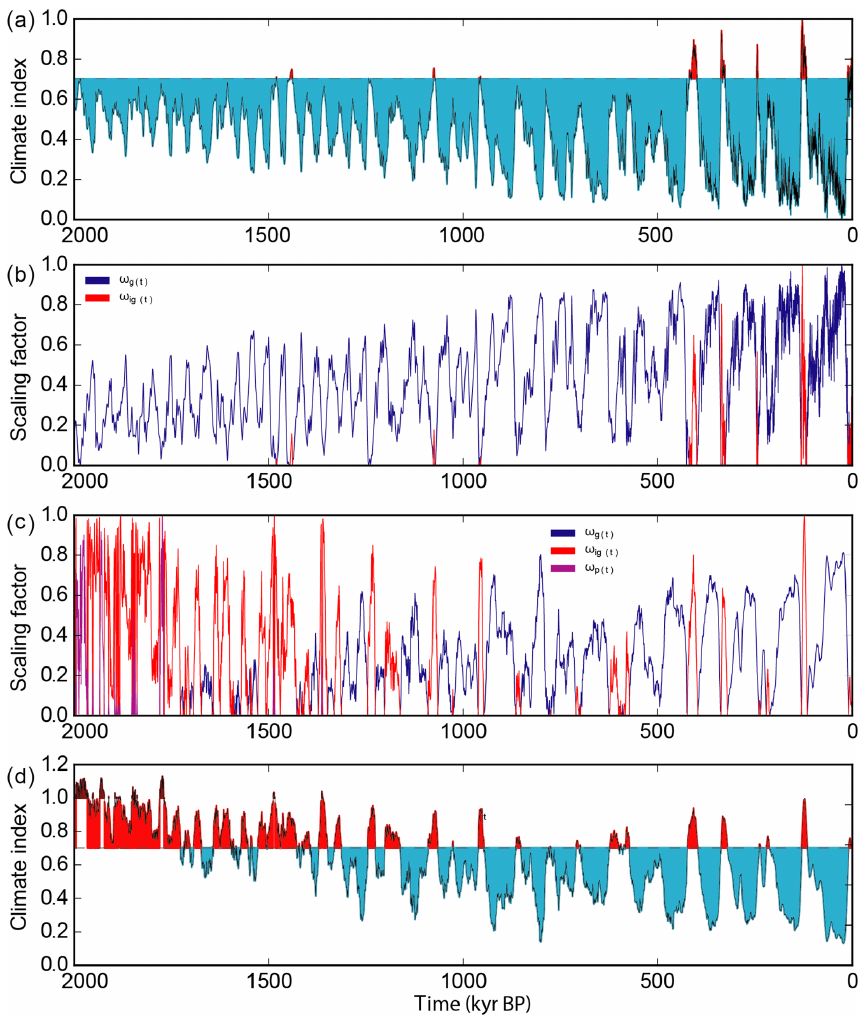
Figure 2. Climate index derived from the Dome C deuterium record (a) and corresponding scaling factors ω x in (b) . Times colder than present are shaded in cyan and times warmer than present in red. (d) same as (a) but for the climate index derived from the Snyder global surface temperature record and scaling factors ω x in (c) . Times warmer than the Last Interglacial are shaded in dark red. The lines in (b) and (c) vanish when scaling factors are